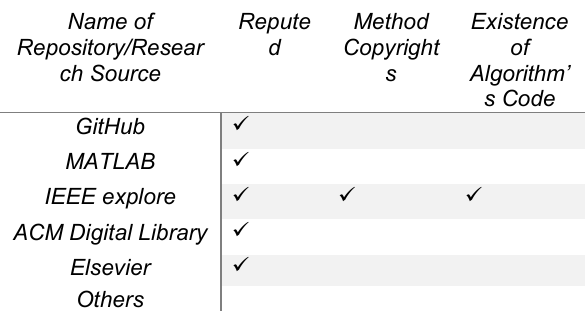
Table 2. RQs Filtration for AOD method